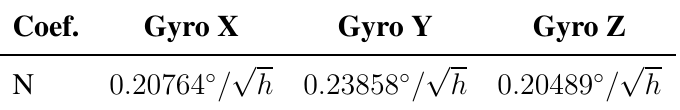
Table 2. Angle random walk noise coefficients for IMT30 gyros. Mean value of five tests.